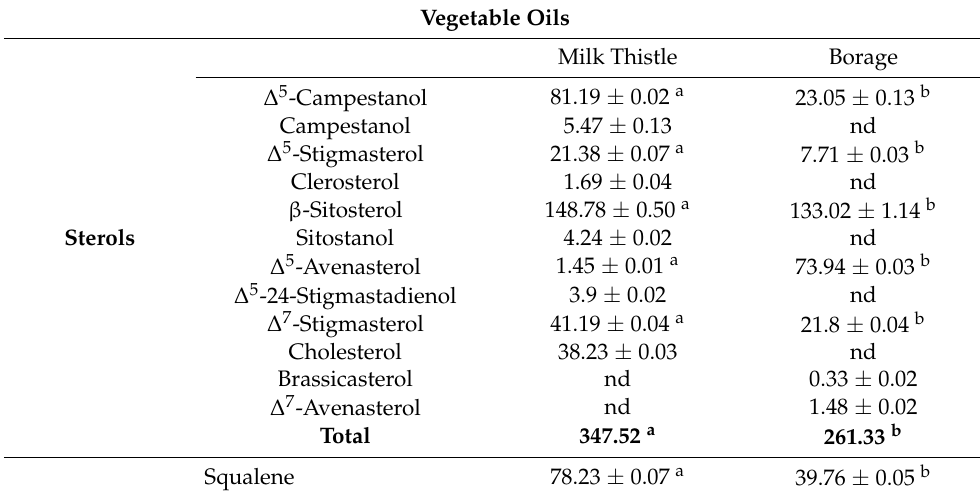
Table 7. Sterol and squalene content (mg · 100 g − 1 oil) in